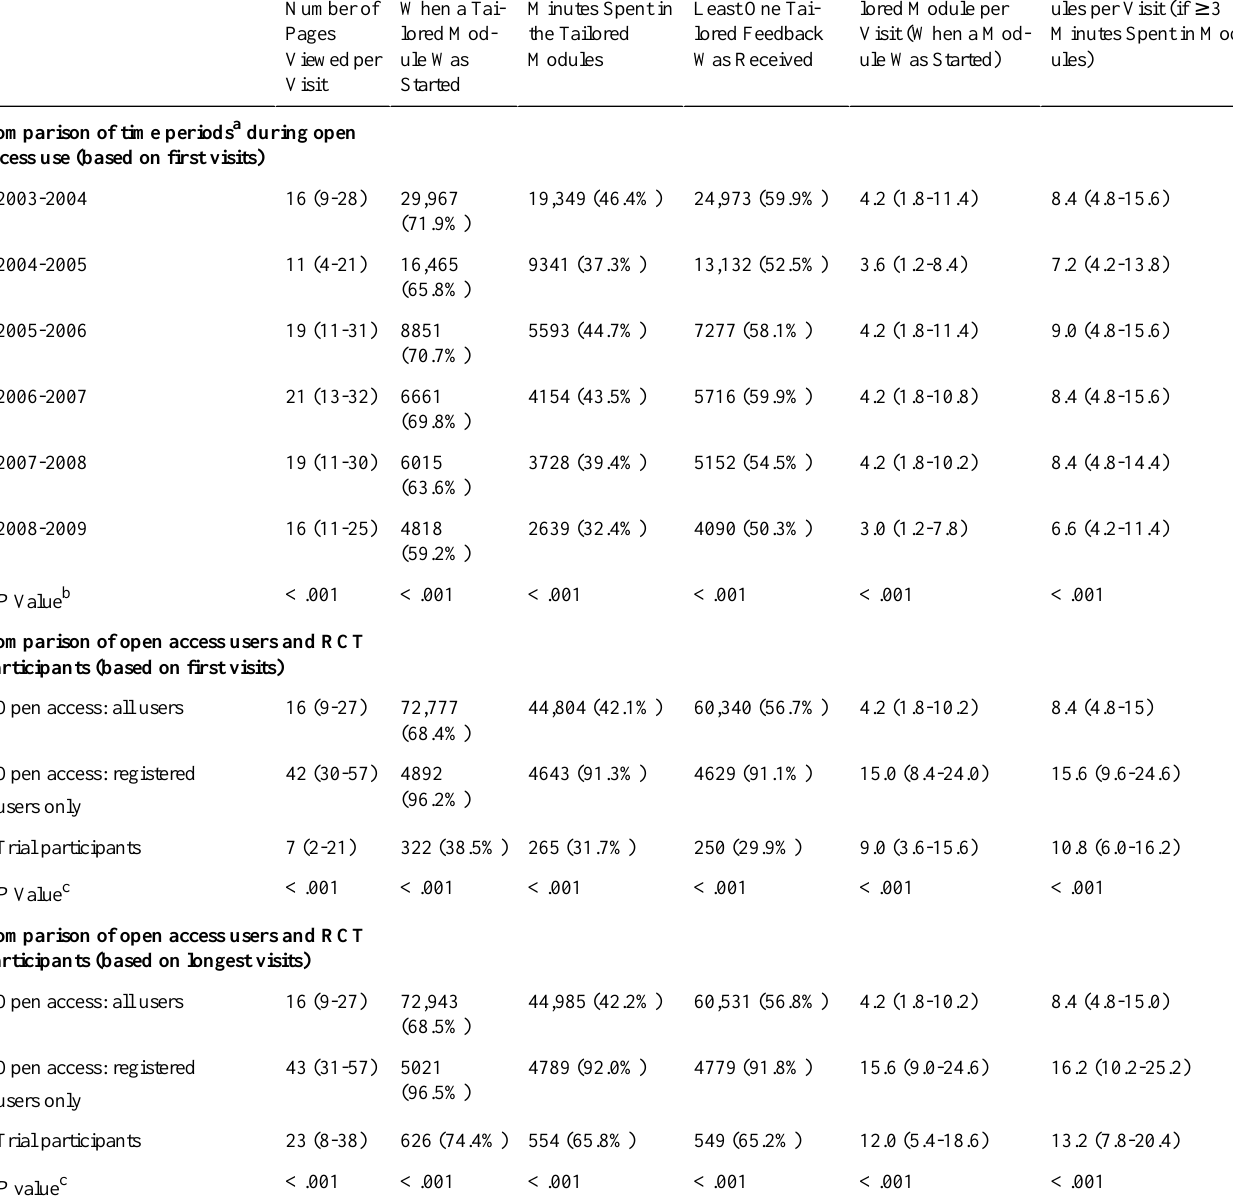
Median (IQR) Minutes Spent in Tailored Mod- ules per Visit (if ≥ 3 Minutes Spent in Mod-